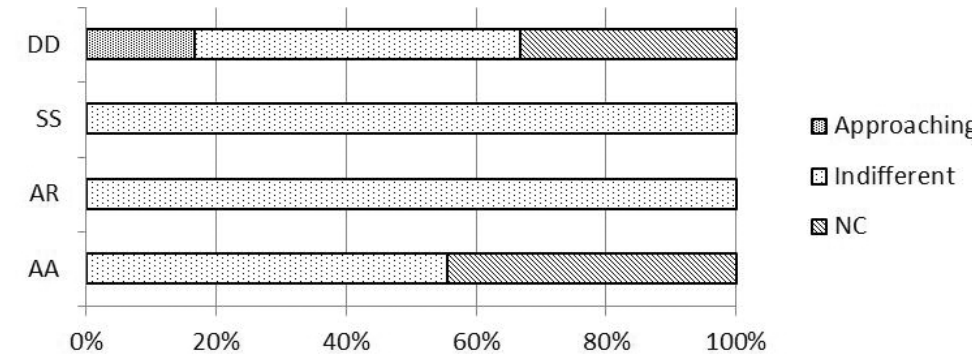
Figure 10. Cetacean responses beyond the 500 m MZ, according with classification on power changing in Table